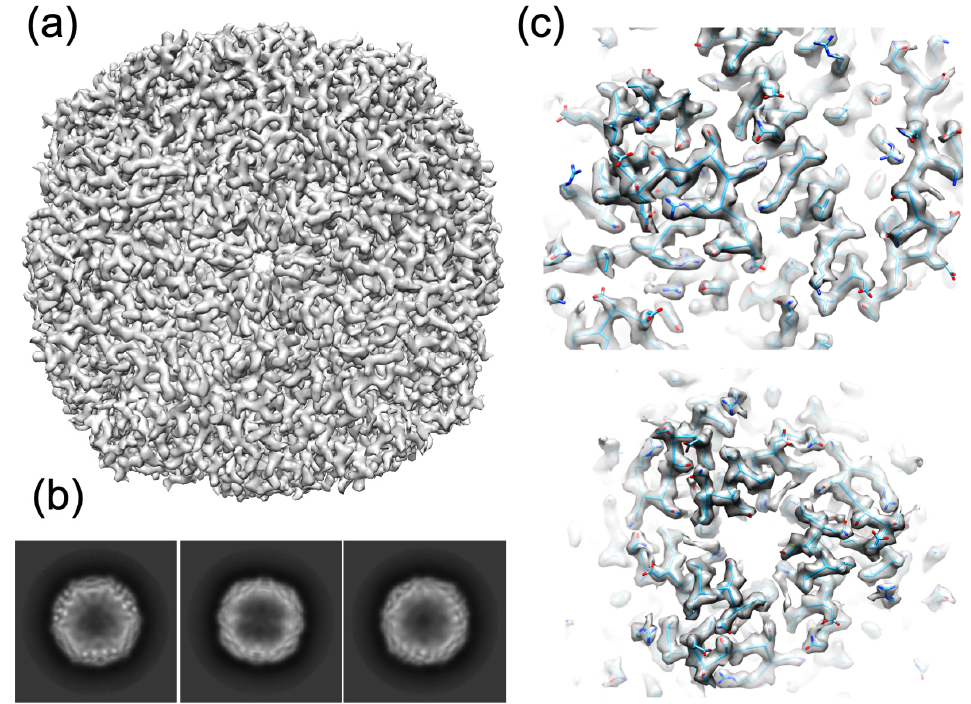
Figure 3. Final apoferritin 3D reconstruction contoured at 2.5 σ ( a ) Isosurface view of the apoferritin 3D reconstruction at 2.40 Å resolution. ( b ) Examples of 2D classes (respectively 8769, 7672 and 9251 particles are averaged in each class); ( c ) two views of the fit of horse spleen apoferritin (PDB code: 4V1W [38]) into the EM density map showing the good quality of the